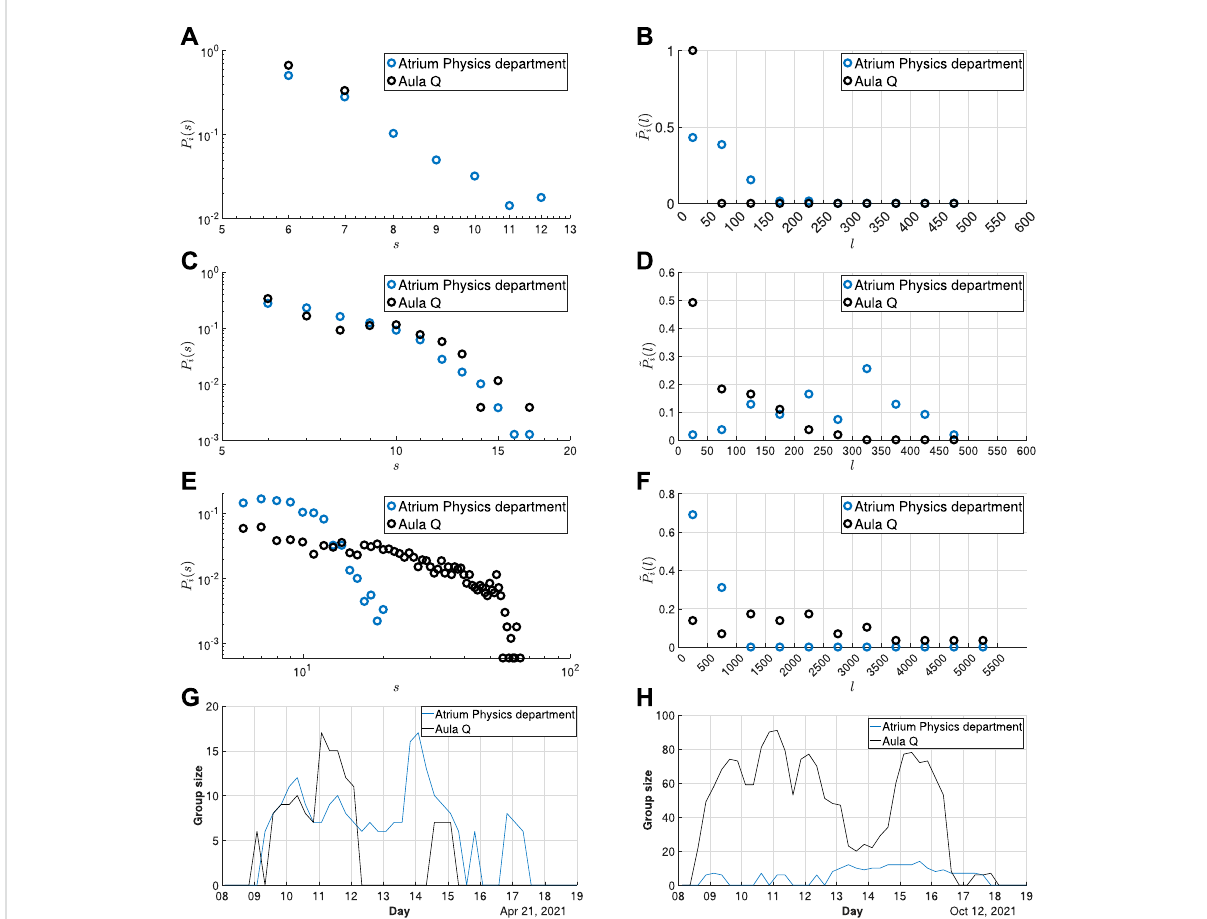
FIGURE 6 ComparisonbetweendifferentAPsofthesimplexsizeanddailylinkmeasures.WeconsidertwoAPsinstalledintwodifferenttypesofareas;one placedinaclassroomandtheotherintheatriumofthephysicsdepartment,andwecomparetheirgroupsizeanddailylinkdistributions. (A,B) Plotof groupsizedistributionanddailylinkduringtheclosingphase.TheAPplacedintheclassroomshowsthatsmallgroupsareformedduetorestrictions. (C,D) For the same APs, we plot the distributions obtained during the partial opening phase. The two APs have a similar group size distribution but different daily link distributions. This shows that the groups in the classroom are more stable than those in the atrium, where the groups are continuously reshuf fl ed. (E,F) Plots show that large gatherings are formed in the classroom due to the return of face-to-face lessons. (G,H) Time evolution of the group size for the two APs during a typical working day in partial opening and total opening, respectively. For small groups with size s < 6, we have set the group size to